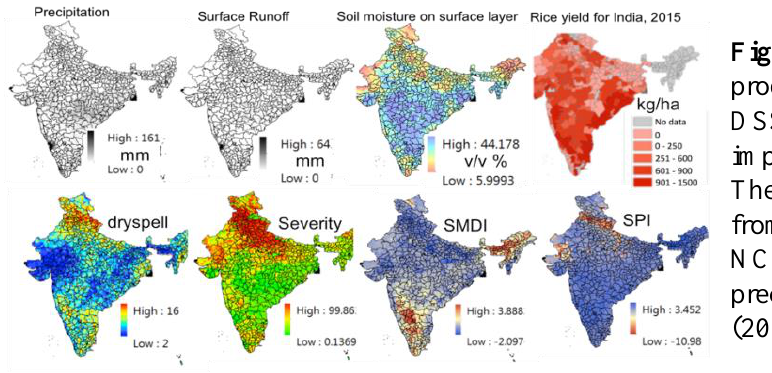
Figure 11 : An example of data product from the RHEAS and M- DSSAT system ready for implementation and operation. The results are for 15 th June, 2015 from the simulation that used the NCEP forcings and CHIRPS precipitation data for five years (2011 to